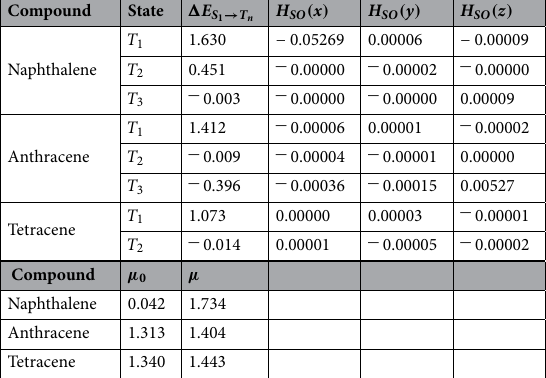
Table 2. Tabulated singlet to triplet quantum chemical transition properties for naphthalene, and collated data for anthracene and tetracene from Ref. 10 , at the S 1 Franck–Condon point. Energy differences are adiabatic, with negative energies defined as transition to a higher state. Energies are given in units of eV, while SOCME terms are in units of cm − 1 . Sub-table shows the Franck–Condon transition dipole moment µ 0 and effective transition dipole moment µ calculated as per Eq. (4), in atomic